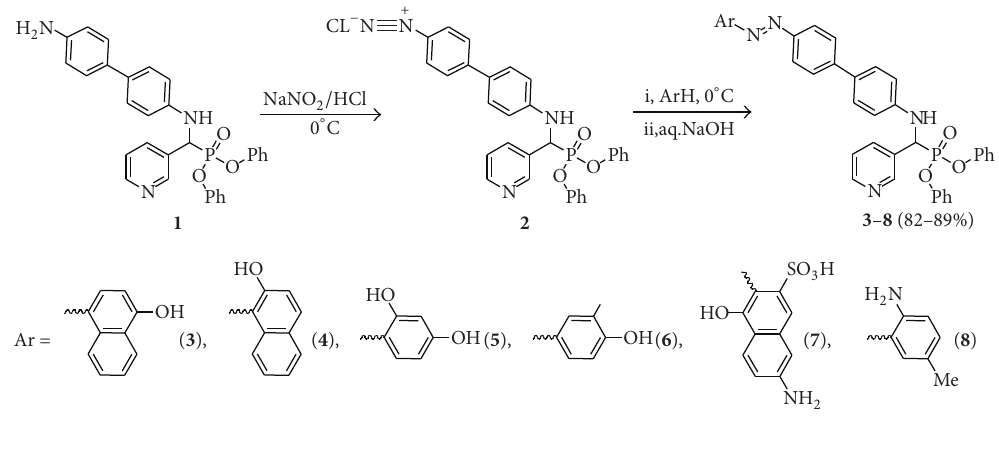
S 2: Synthesis of azo dyes 3–8